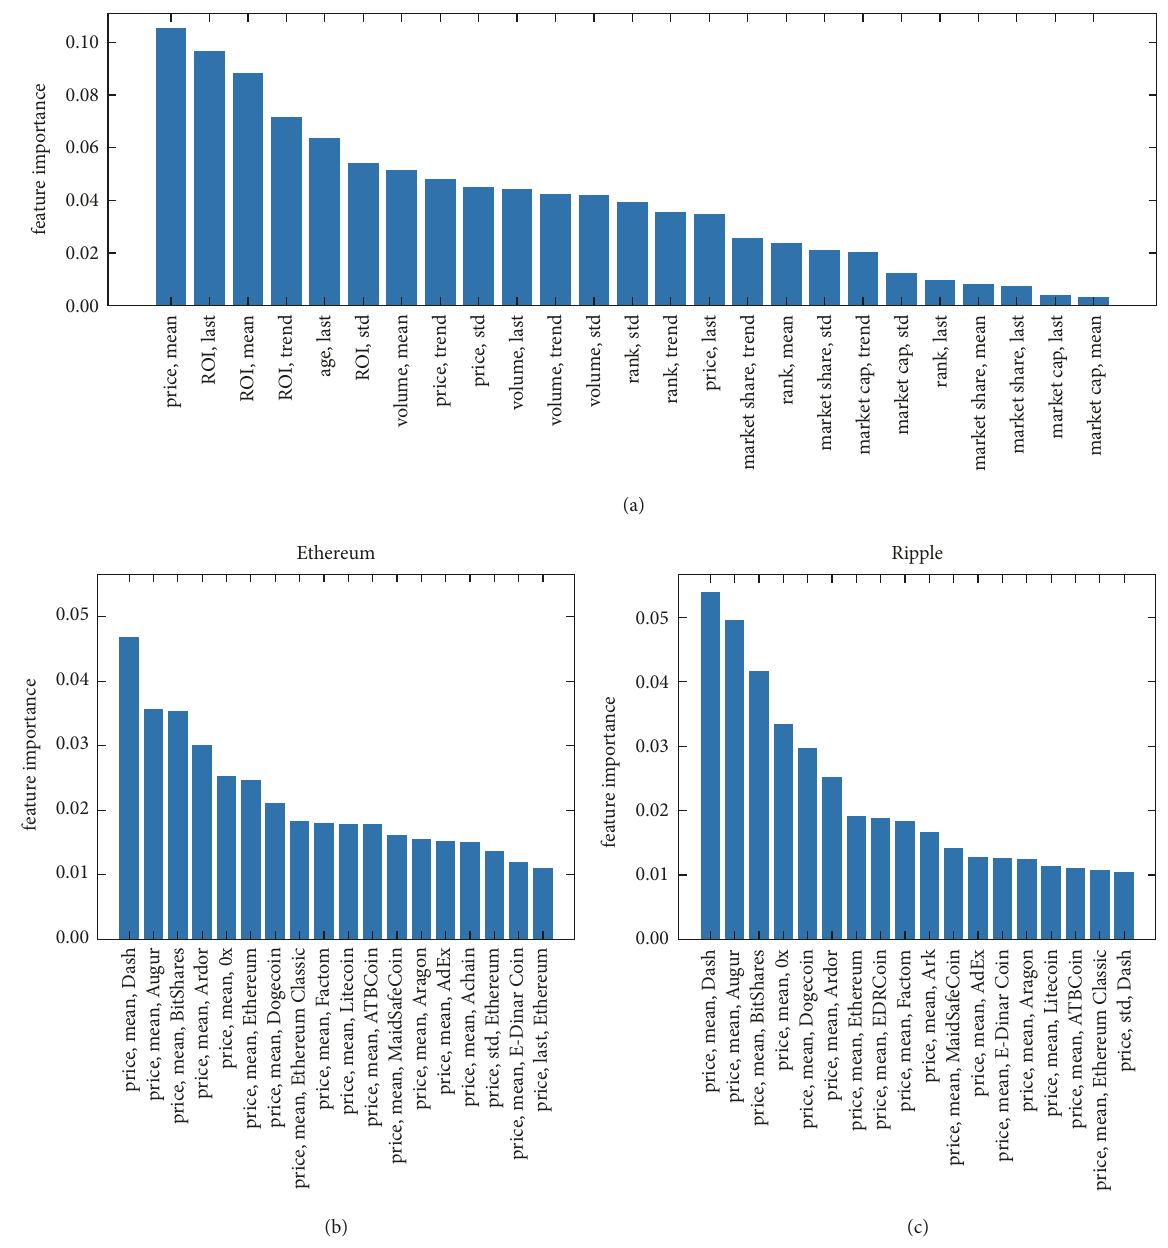
Figure 7: Feature importance for Methods 1 and 2. (a) The averageimportance of each feature for the XGBoost regression model of Method 1. Results are shown for 𝑤 = 7 and 𝑊 𝑡𝑟𝑎𝑖𝑛𝑖𝑛𝑔 = 10 . (b, c) Examples of average feature importance for the XGBoost regression model developed in Method 2. Results are shown for 𝑤 = 3 , 𝑊 𝑡𝑟𝑎𝑖𝑛𝑖𝑛𝑔 = 10 , for Ethereum (b) and Ripple (c). For visualization purposes, we show only the top